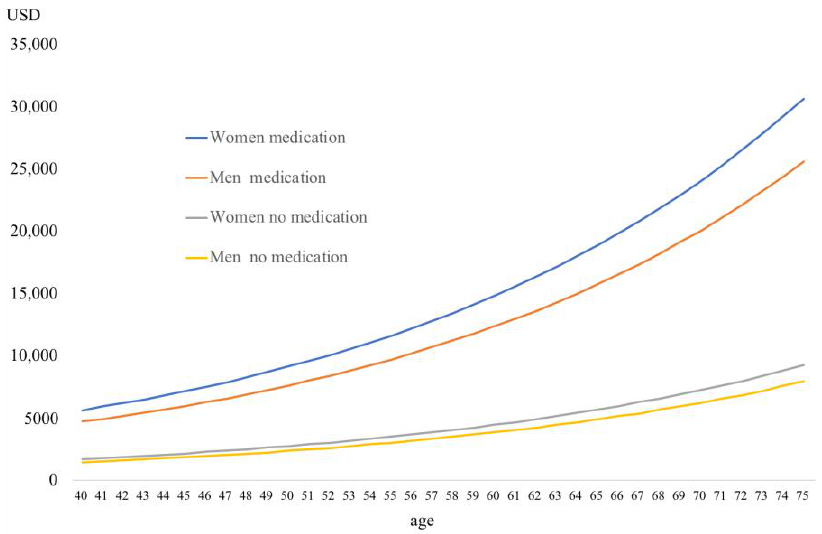
Figure 1. Five-year cumulative outpatient and medication expenditure by medication status.